Question: Give a one-sentence summary of this figure.
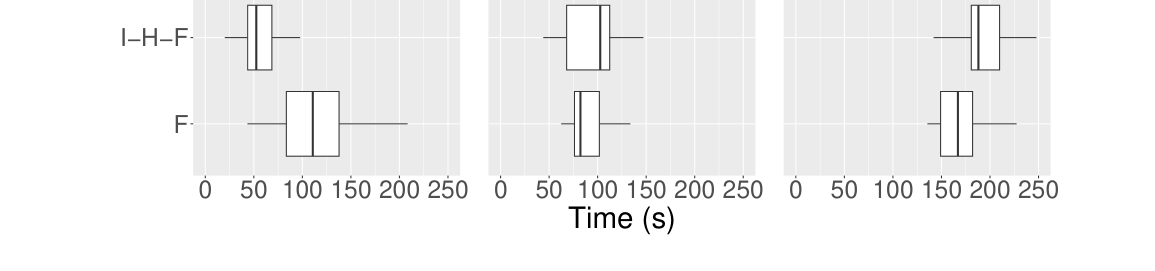
Answer: Simulation 1: boxplots of computational time (s) for each model selection approach and different values of n.